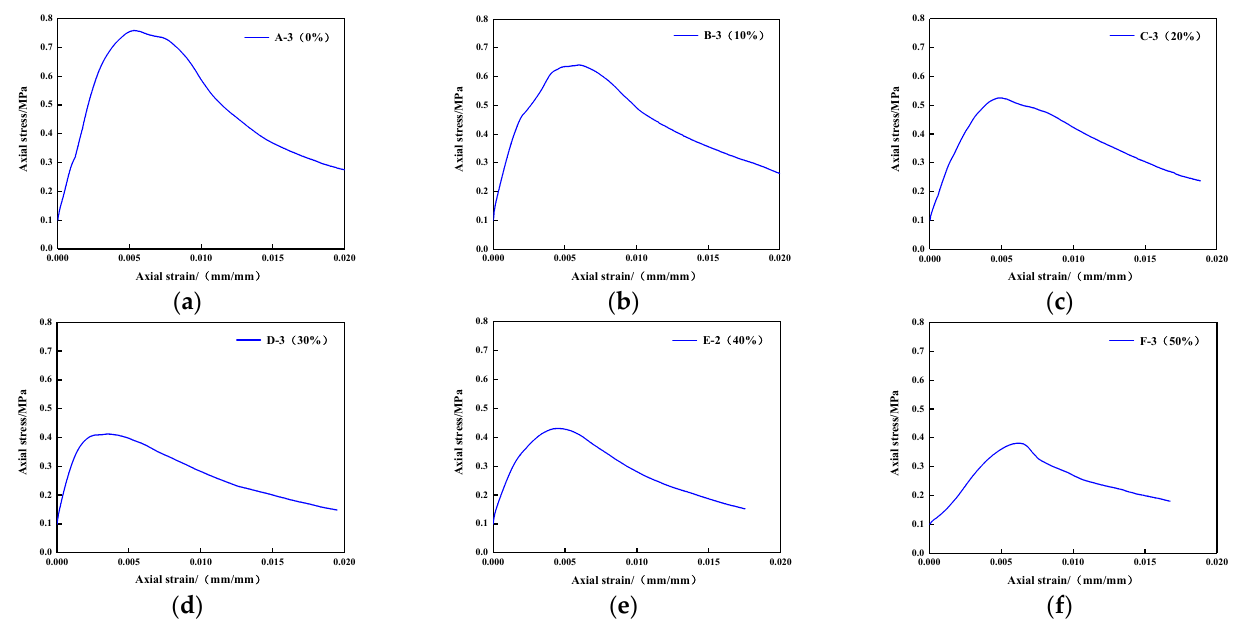
Figure 5. Stress–strain curves of CGFB samples. ( a ) A-3; ( b ) B-3; ( c ) C-3; ( d ) D-3; ( e ) E-2; ( f ) F-3.